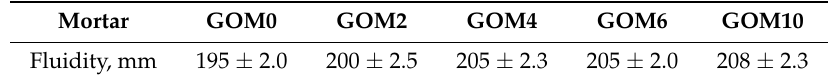
Table 7. Mortar fluidity.